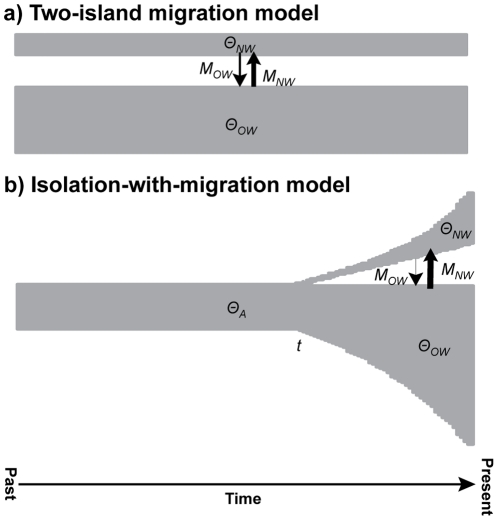
Basic population models.Illustrations of the two-island (a) and isolation-migration (b) models of population subdivision inferred in this study.